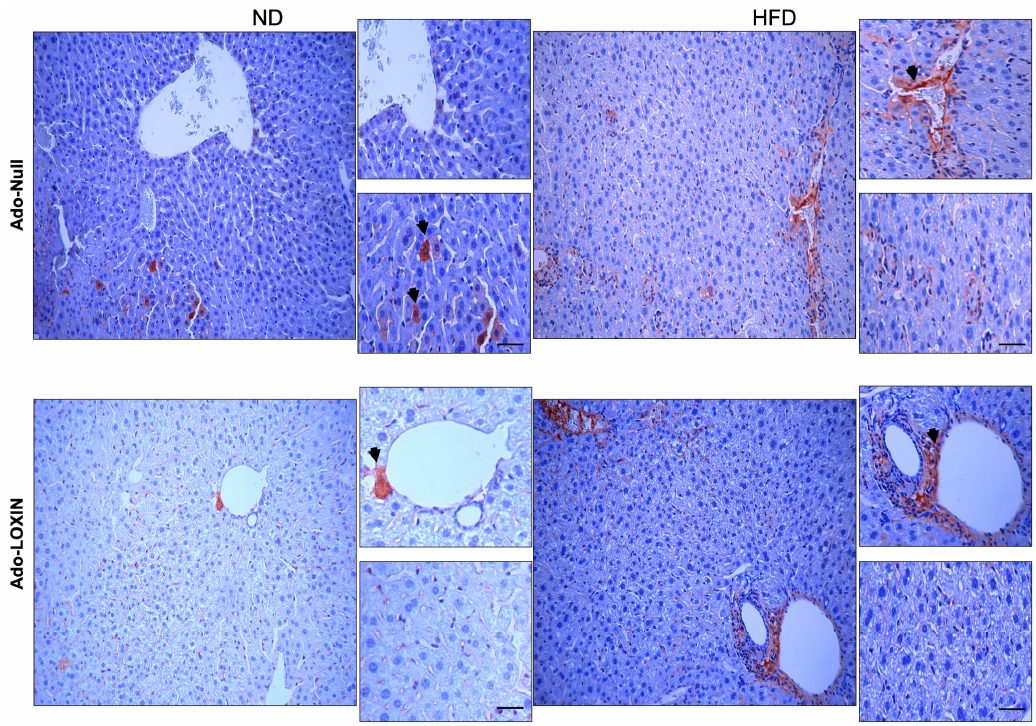
Figure 7. Hepatic TNF- α accumulation in the liver of each treated group of mice. Representative histological findings with immunohistochemical staining for TNF- α (original magnification, X400). The arrows indicate cells positive for TNF- α . Scale bars indicate 10 µ m.